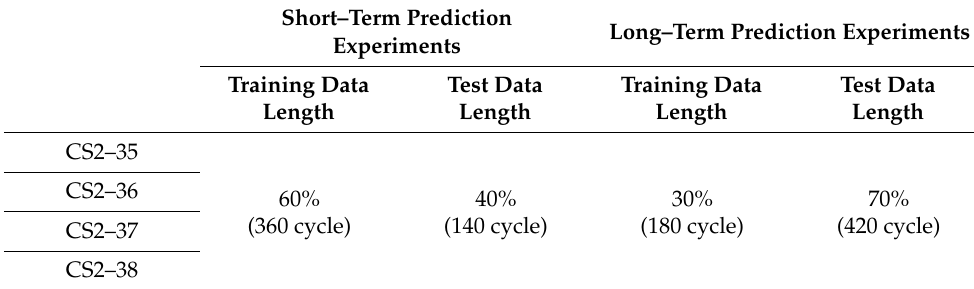
Table 4. Experimental classification and the basis of